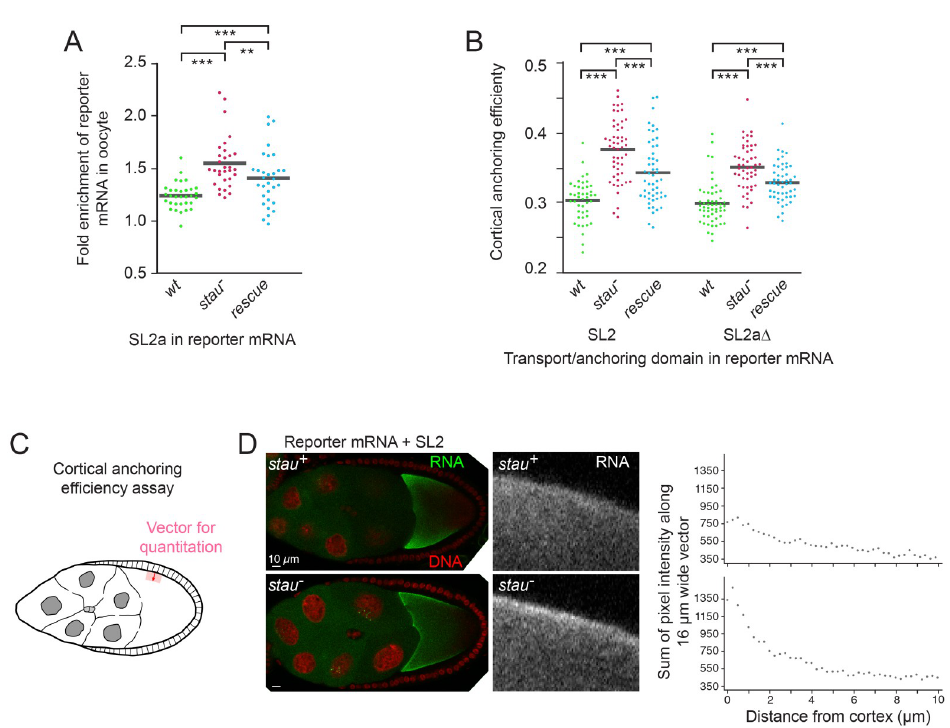
Fig 7. STAU inhibits TAS transport and cortical anchoring activities. Reporter mRNAs with the SL2a domain of osk (panel A) or forms of the TAS (panel B) were expressed in wild type (wt), homozygous stau C mutant ( stau - ) or homozygous stau C mutant with a stau + transgene (rescue) ovaries. (A) Efficiency of RNA transport to the oocyte was measured by comparing reporter mRNA levels in nurse cells and oocyte of individual stage 4–6 egg chambers (Materials and methods). Transport was elevated in the absence of stau , and this effect was substantially reversed by the stau + transgene. The failure to completely reverse the elevated transport (as well as the elevated cortical anchoring in panel B) may be due to differences in stau gene dosage, as the rescuing transgene is present in only one copy, or could be due to lower expression from the transgene relative to the endogenous stau gene. Results are presented in dot plot format. N values were at least 31 for all genotypes. Statistical significance was evaluated by one-way ANOVA with F(2,91) = 15.52, P < 2 x 10 − 6 . Normality was rejected (Bonferroni corrected Shapiro-Wilk test), therefore the Wilcoxon rank sum test was used for post hoc analysis. ��� : P < 0.01, �� : P < 0.05. (B) Efficiency of RNA cortical anchoring was measured in early stage 9 egg chambers using the approach outlined in panel C. Both forms of SL2a showed enhanced anchoring in the absence of STAU, and this effect was significantly reversed by the stau + transgene. Results are presented in dot plot format. N values were at least 44 for all genotypes. Statistical significance was evaluated by one- way ANOVA with F(5,296) = 33.90, P < 3 x 10 − 27 . Normality was rejected (Bonferroni corrected Shapiro-Wilk test), therefore the Wilcoxon rank sum test was used for post hoc analysis. ��� : P < 0.01. (C) Schematic diagram of the approach to measure cortical anchoring efficiency. A 10 μ m vector (dark red line with arrowhead) was drawn from the lateral cortex towards the interior of the oocyte. At intervals along the vector, but 16 μ m wide (red shaded area), signal intensities were measured. Cortical efficiency was calculated as the proportion of signal in the first 2.5 μ m relative to the summed signal along the entire vector. (D) Examples of egg chambers scored for cortical anchoring efficiency, in the wild-type background at top and the stau mutant background at bottom. At left are the egg chambers showing the distribution of the reporter mRNA + SL2, with magnified portions of the cortical region and only the RNA signal at center. At right are the pixel intensities along the vector as measured in the assay using the same egg chambers.